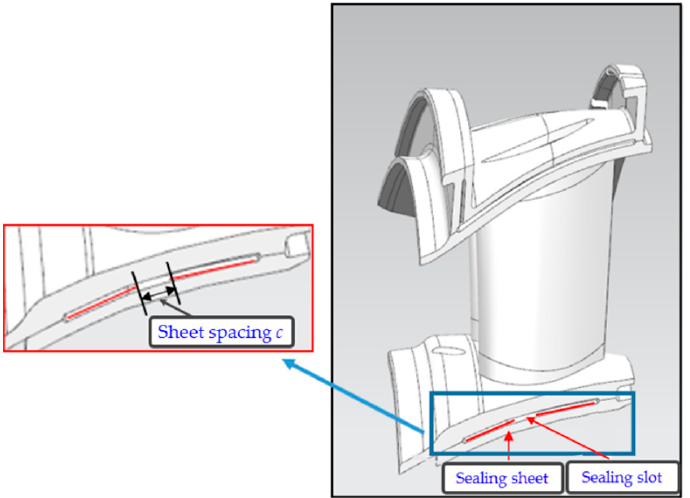
Figure 6. Schematic diagram of the sheet spacing for the sealing sheet structure.